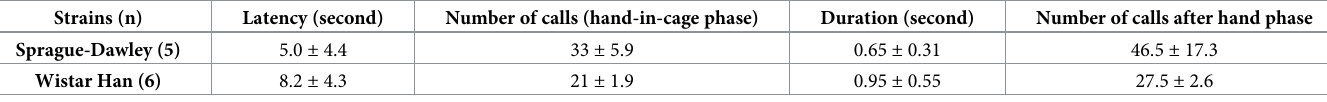
Table 2. Characteristics of hand-induced 22-kHz vocalizations in male SD and WH rats (mean ± SD). Strains